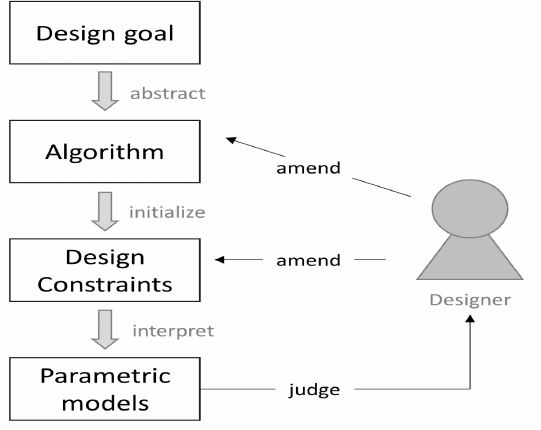
Figure 1. Relationship of GD components and the process of running a